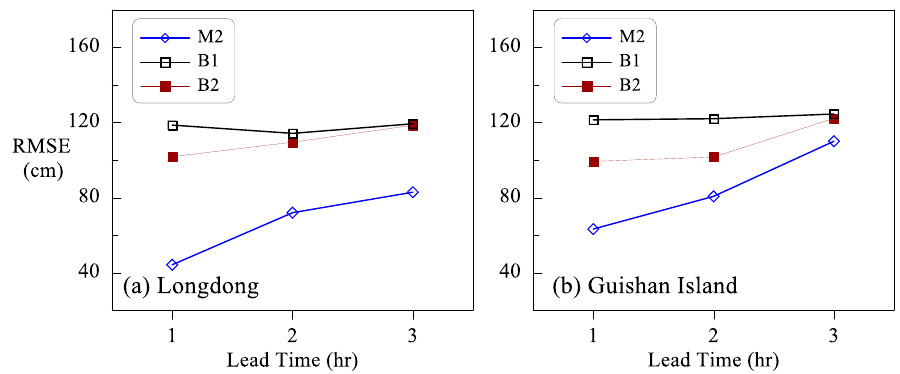
Figure 10. Forecasting performance in terms of RMSEs for backup systems during the validation phase for ( a ) Longdong and ( b ) Guishan Island.